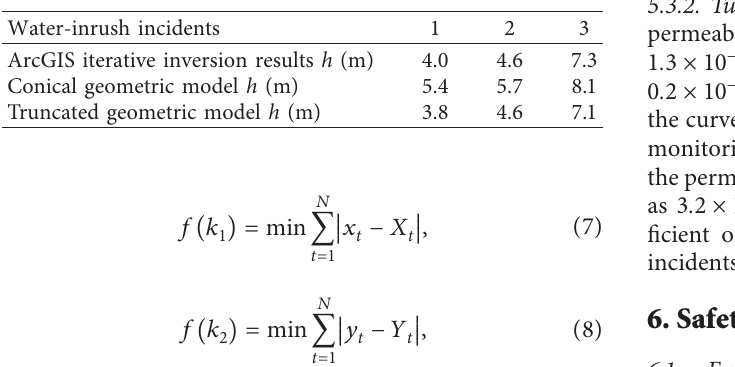
Table 7: Calculation results based on water-inrush incidents.